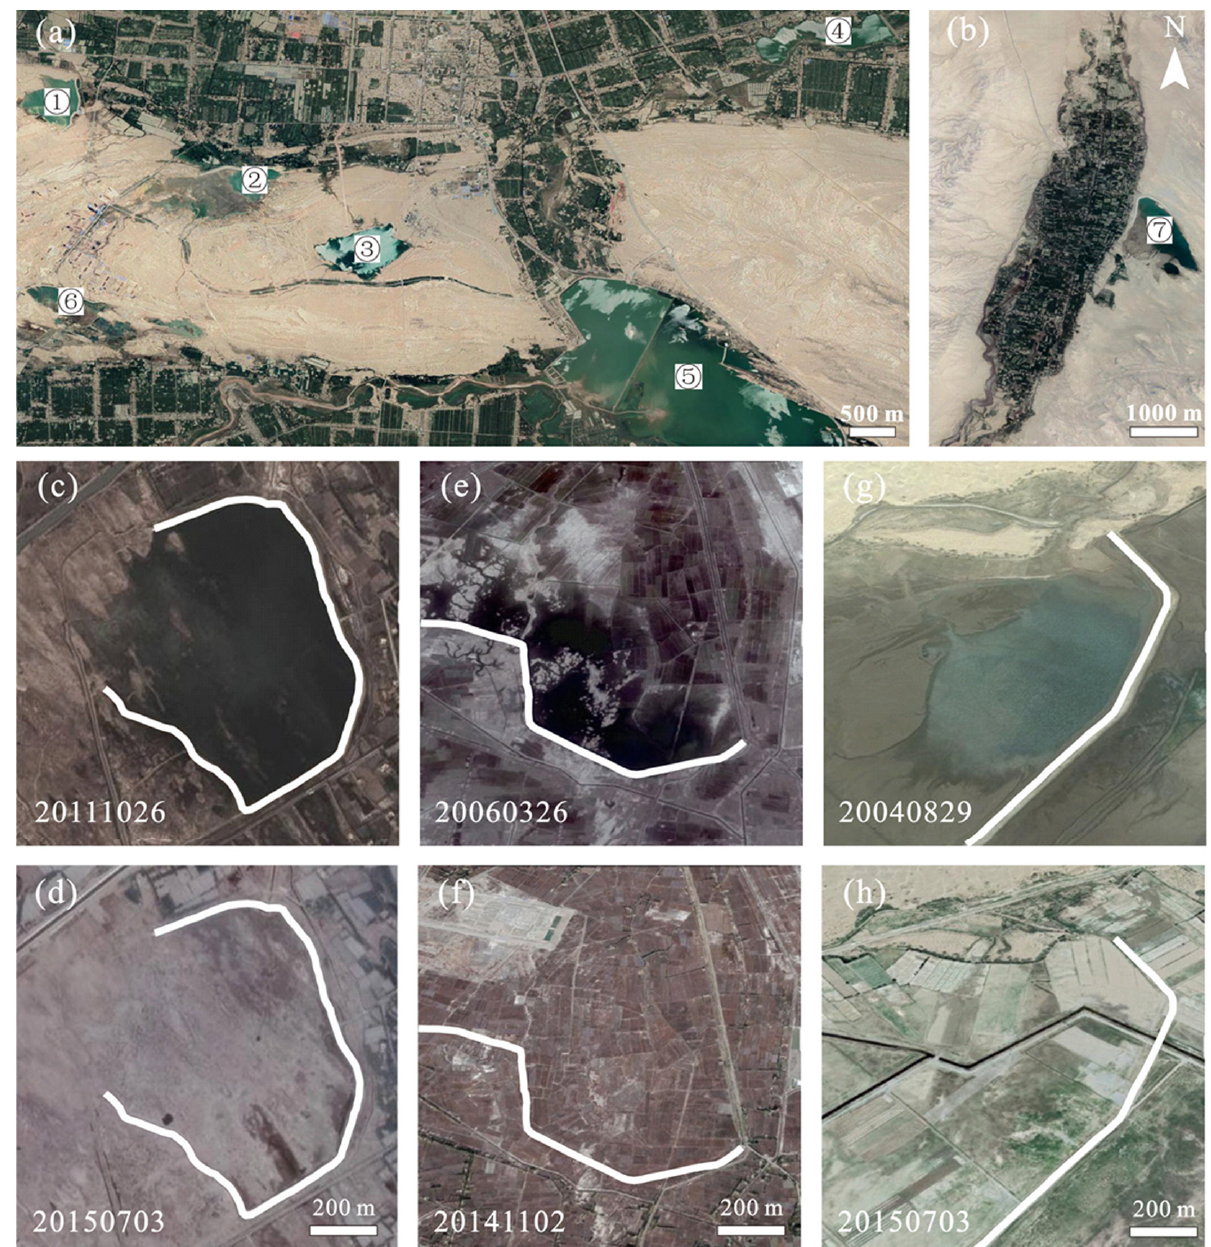
Figure 7. Example of reservoir evolution in TB from 1990 to 2019 (image from Google Earth): ( a ) Multiple water supply bodies serving a single receiving water body; ( b ) single water supply serv- ing a single water body; ( c , d ) Paikeqi Reservoir in the Yarkant River Basin; ( e , f ) Minbing Reser-voir in the Weigan River Basin; and ( g , h ) Jinxing Reservoir in Hotan River Basin.